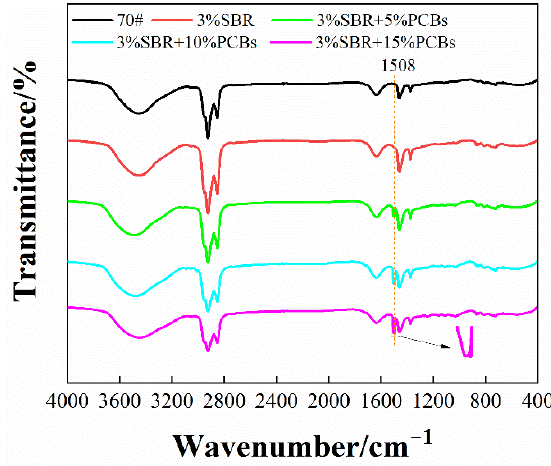
Figure 7. Fourier transform infrared spectroscopy.